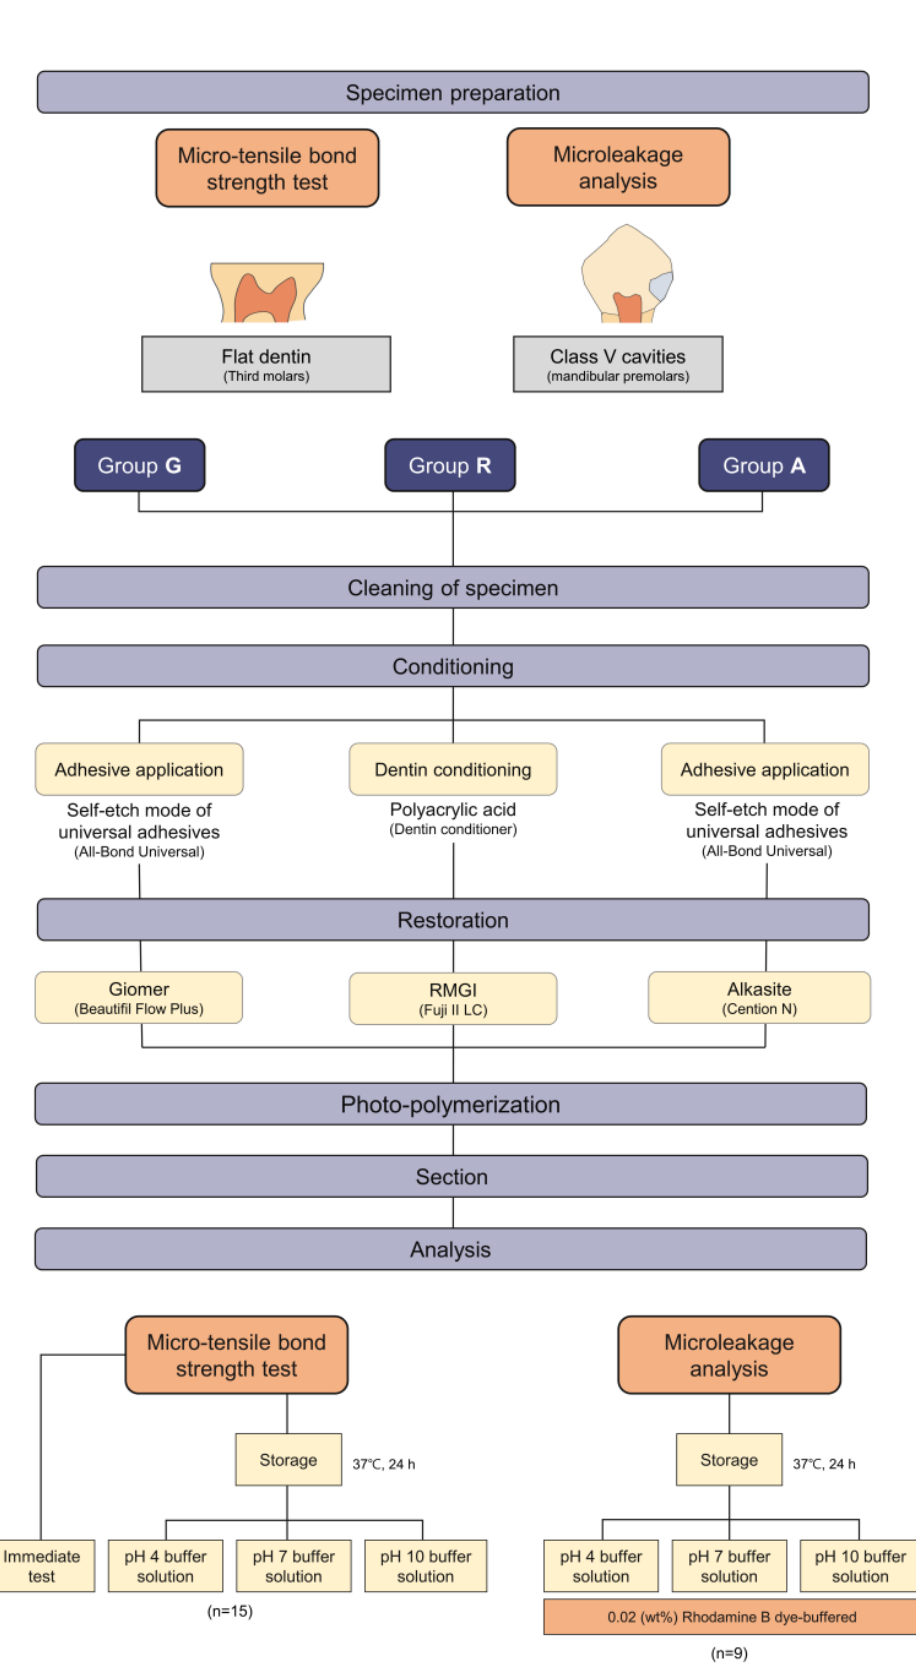
Figure 1. The scheme of the study and classification of experimental groups.